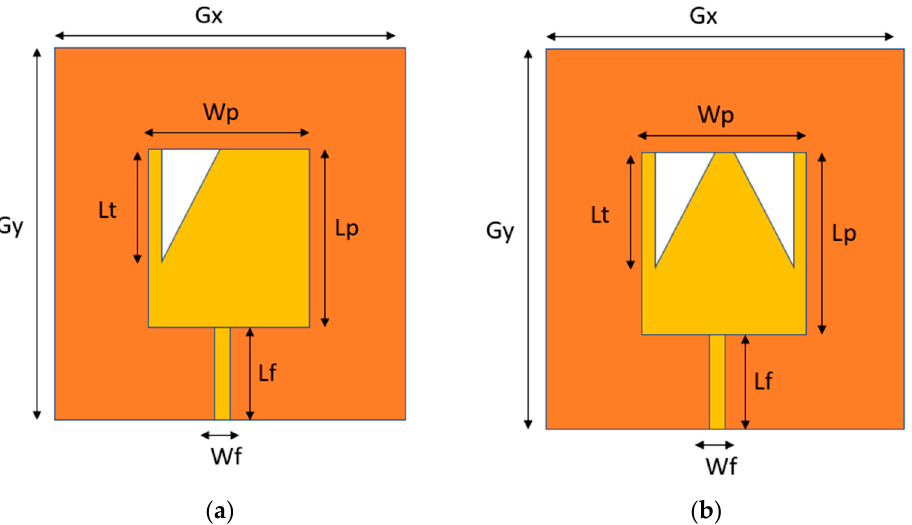
Figure 3. ( a ) Rectangular patch antenna design with single V − shaped extrudes; ( b ) Rectangular patch antenna design with two V-shaped extrudes.